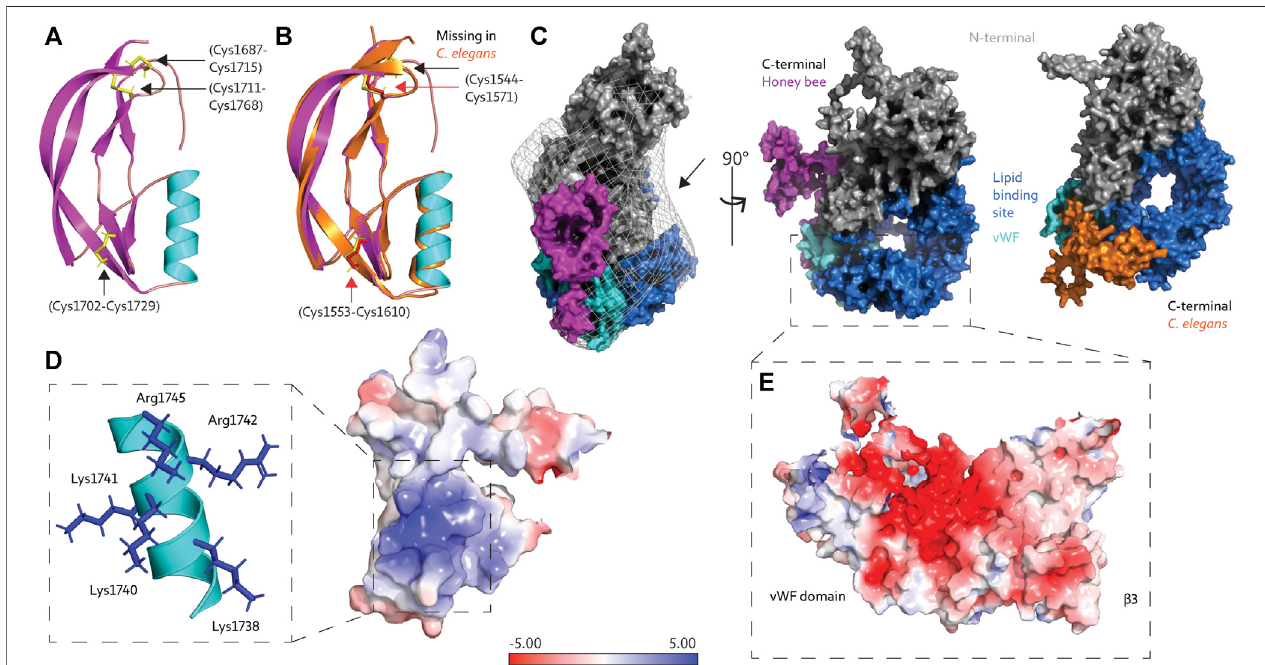
FIGURE 2 | (A) The C-terminal region of honey bee Vg is composed of an α -helix (cyan) and four short and two longer β -strands (magenta), connected by three disul fi de bridges (yellow sticks, black arrows). (B) The C-terminal region from C. elegans Vg-2 (orange) superimposed honey bee Vg (the same colors as in panel A) and hastwodisul fi debridges(redsticksandarrows),while thethird,asseeninhoneybeeVg,ismissing(blackarrow). (C) Proteinsurfacerepresentation offull-length honey bee Vg with the N-terminal domain colored gray, the lipid binding site including the vWF domain colored blue and cyan, respectively, and the C-terminal colored magenta. We show the EM map density barriers as a grid representation around the surface. The black arrow points to the available density above the lipid binding site. Honey bee Vg is turned 90 ° about the y-axis compared to the presented C. elegans Vg-2, shown from the same angle and colored the same, except the C-terminal is coloredorange. (D) Thepositivelychargedresidues(bluesticks)onthe α -helix(cyan)contributetoapositivelychargedsurfaceregion. (E) Thenegativelychargedsurface of β 3 and the vWF domain are shown. In panels D and E, the electrostatic charges are calculated using the APBS plugin in